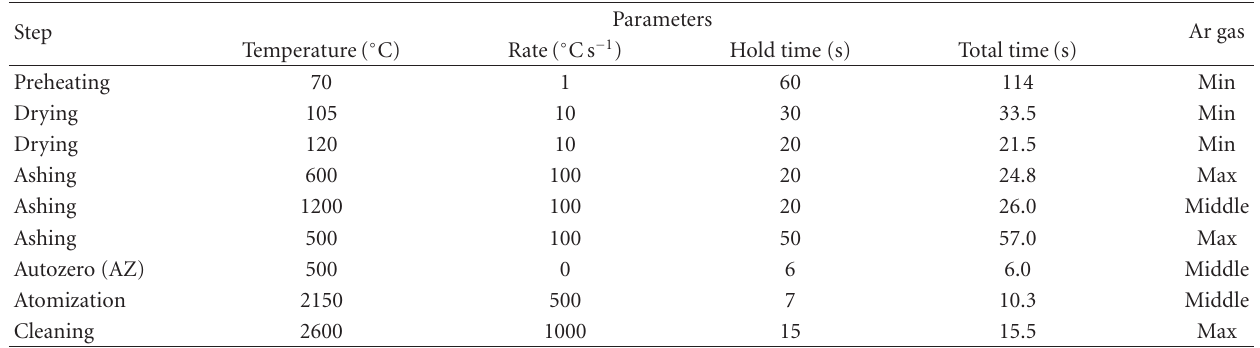
Table 2: Optimized furnace program for the analysis of coal fly ash (solid sampling system).